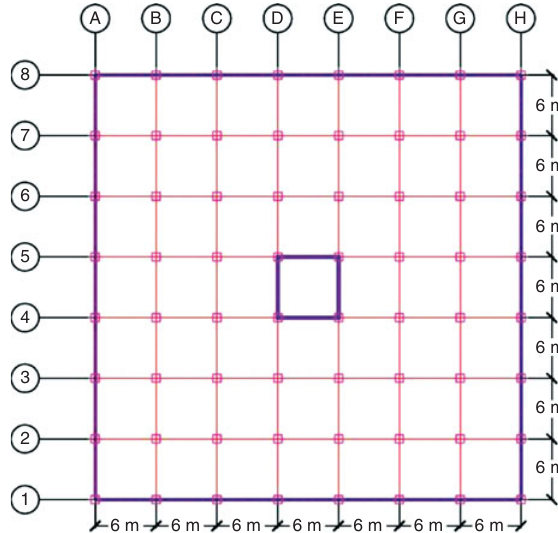
Fig. 1. Common plan view for modelling of multi-storey